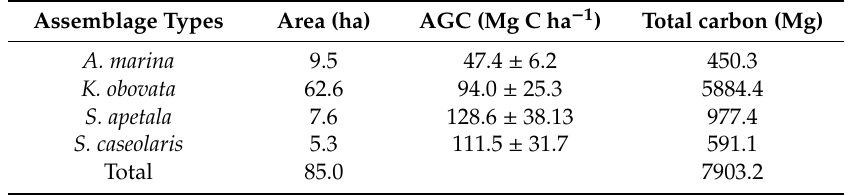
Figure 7. Aboveground carbon stock (AGC) values of the mangrove forest in the Futian Mangrove National Nature Reserve (FMNNR) based on an Random Forest model with 30 variables. Table 5. Estimated aboveground carbon stock (AGC) values of four mangrove assemblages.